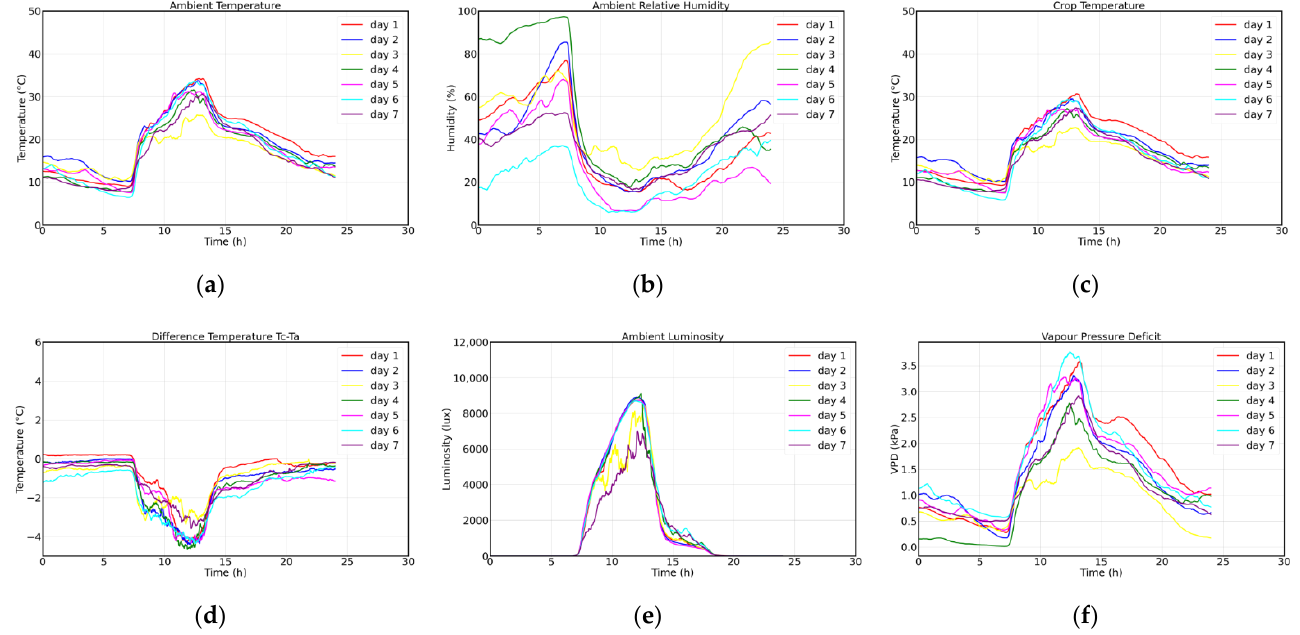
Figure 11. Registration of environmental variables and markers of water stress. ( a ) Ambient temperature; ( b ) ambient relative humidity; ( c ) crop temperature; ( d ) crop—ambient temperature difference; ( e ) luminosity; ( f ) vapor pressure deficit.